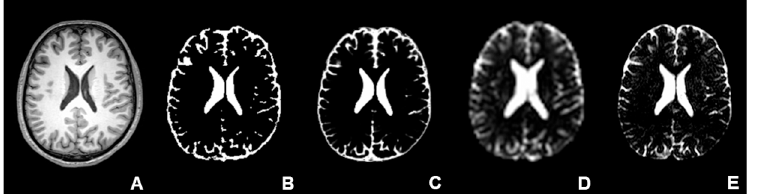
Fig 3. All CSF measurements for all methods in each subject. One slice from subject 8 from A) the HR T 1 -weighted image (downsampled images have the same in-plane resolution); B) 3D T 1 -weighted FSL HR; C) 3D T 1 -weighted SPM HR; D) postprocessed CSF LR; E) postprocessed CSF HR. No image is presented for FreeSurfer, because FreeSurfer uses the determinant of the transformation matrix to estimate ICV rather than distinguishing the skull from peripheral CSF.